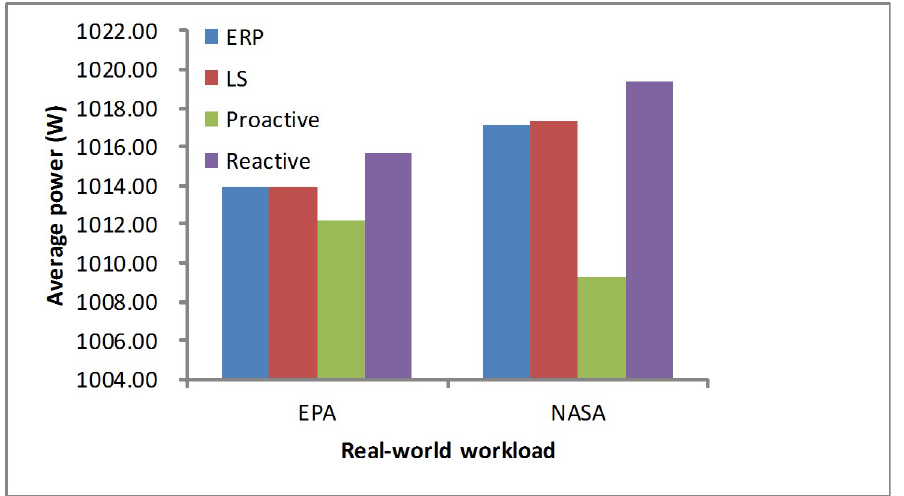
Fig 19. Energy consumption in the real-world